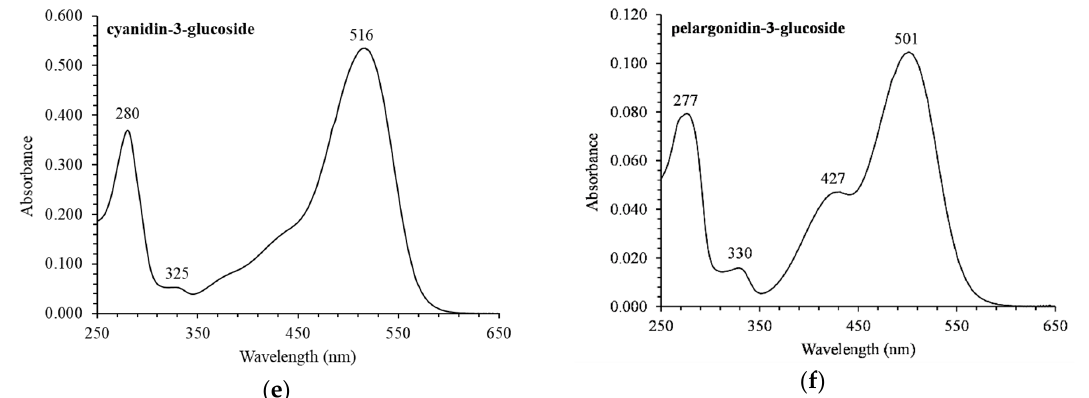
Figure 3. UV-Vis spectra of the ACNs found in PJ from the Ermioni variety: ( a ) Dp-3,5-diglucoside; ( b ) Cy-3,5-diglucoside; ( c ) Pg-3,5-diglucoside; ( d ) Dp-3-glucoside; ( e ) Cy-3-glucoside; ( f ) pelargonidin-3-glucoside.